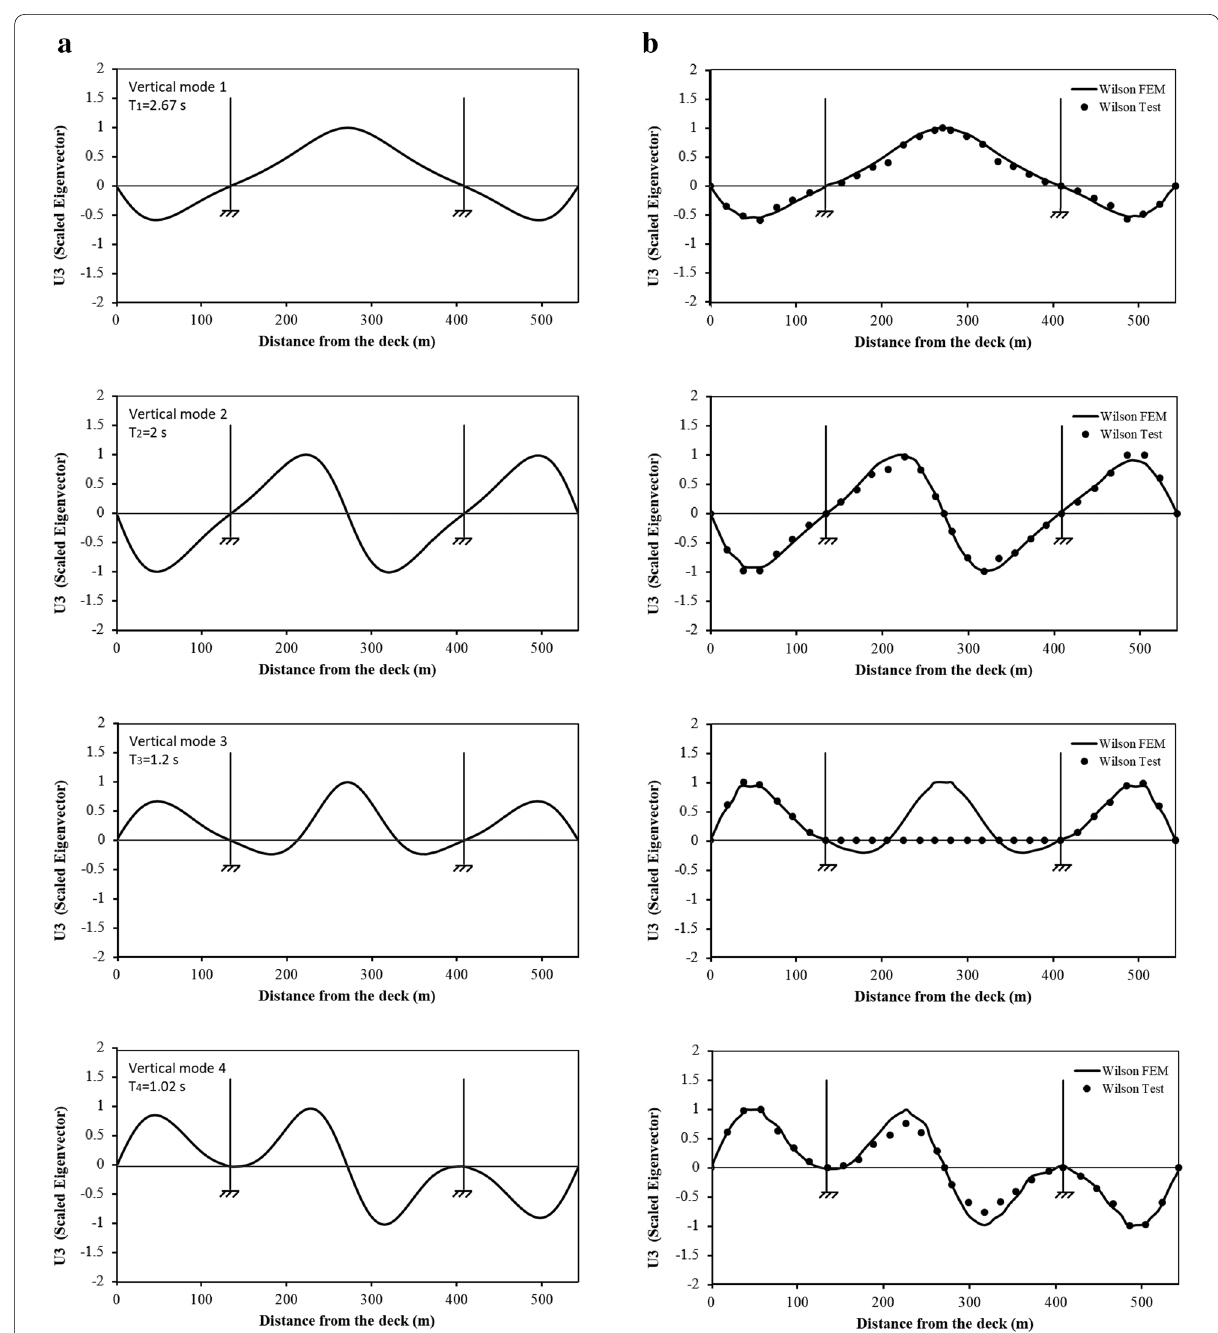
Fig. 3 Vertical mode shapes: a CFEM results, b Wilson FEM and Wilson test